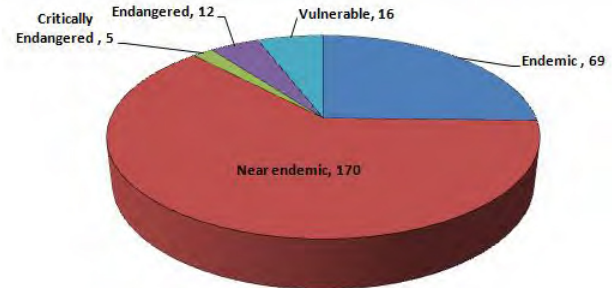
Figure 5. Pie diagram showing endemic, near endemic and threatened species in Sangla valley.